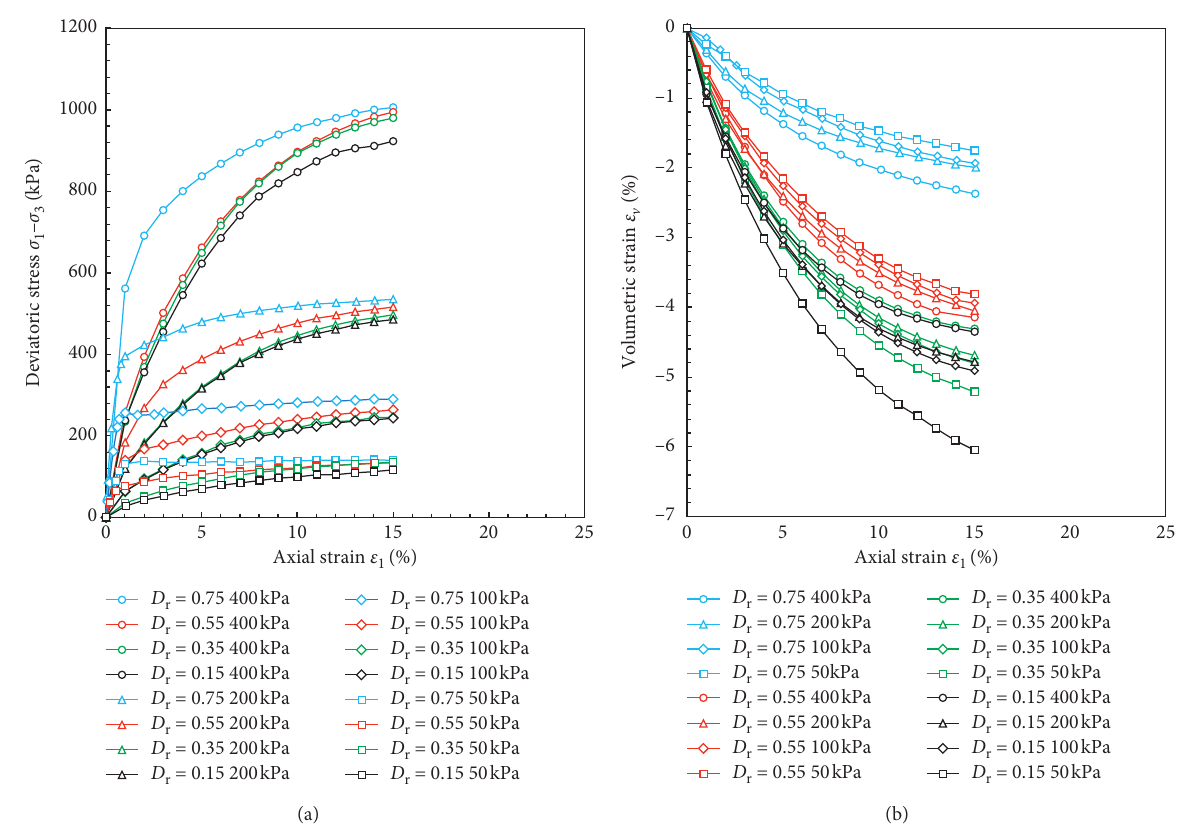
Figure 5: Triaxial shear test results for gravelly sand. (a) Deviator stress-axial strain curves. (b) Volumetric strain-axial strain curves.